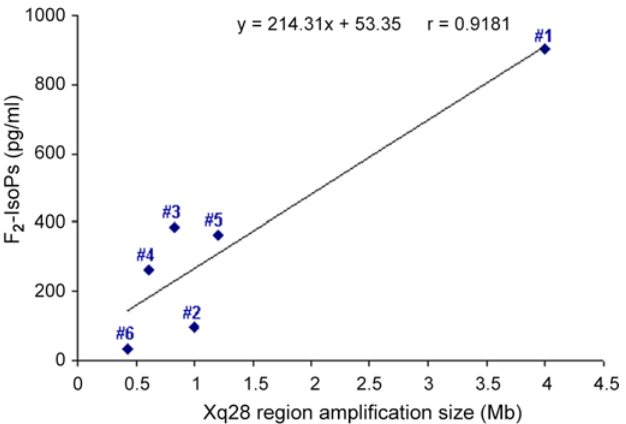
Fig 3. Relationship between plasma F 2 -IsoPs and Xq28 size (univariate regression analysis). A positive linear relationship of plasma F 2 -IsoPs vs. Xq28 duplication/triplication size is showed. The strength of the relationship is indicated by the correlation coefficient (r = 0.9181, P = 0.0098). The linear regression equation was reported.